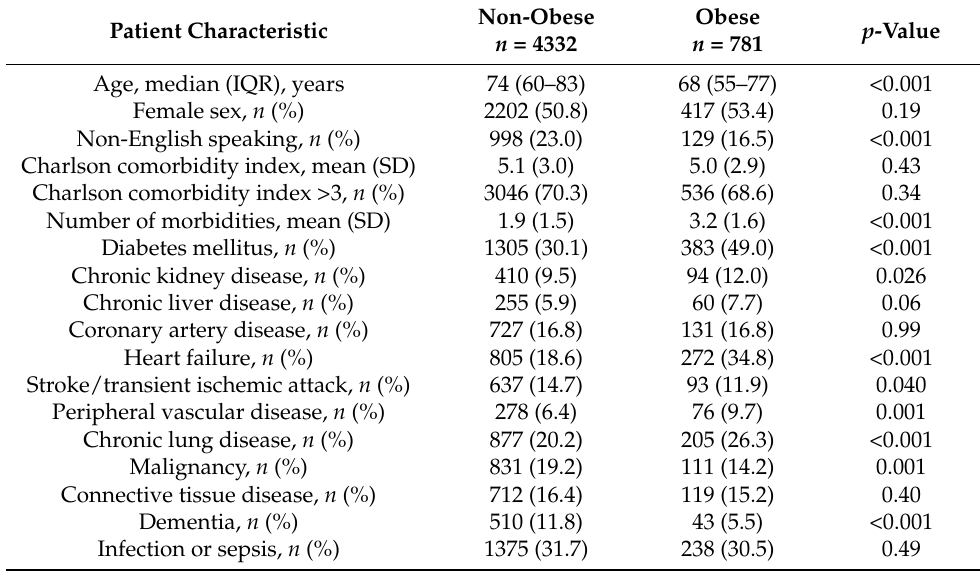
Figure 1. Study flow diagram. DAMA = Discharged against medical advice. Table 2. Baseline characteristics of general medicine patients by obesity status ( n = 5113).